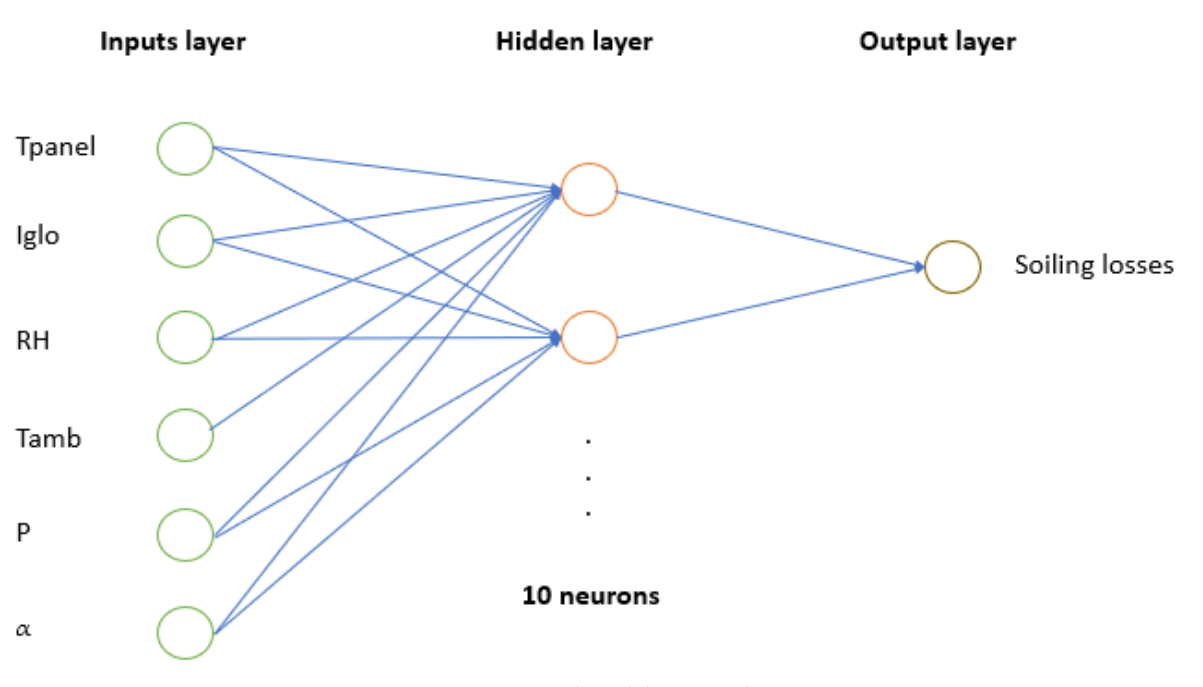
Figure 3. Initial Model 1 network.